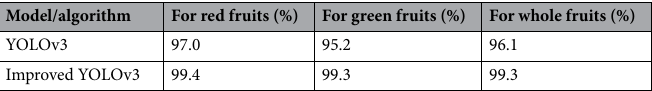
Table 4. Statistics of accuracy of tomato fruit yield estimation.